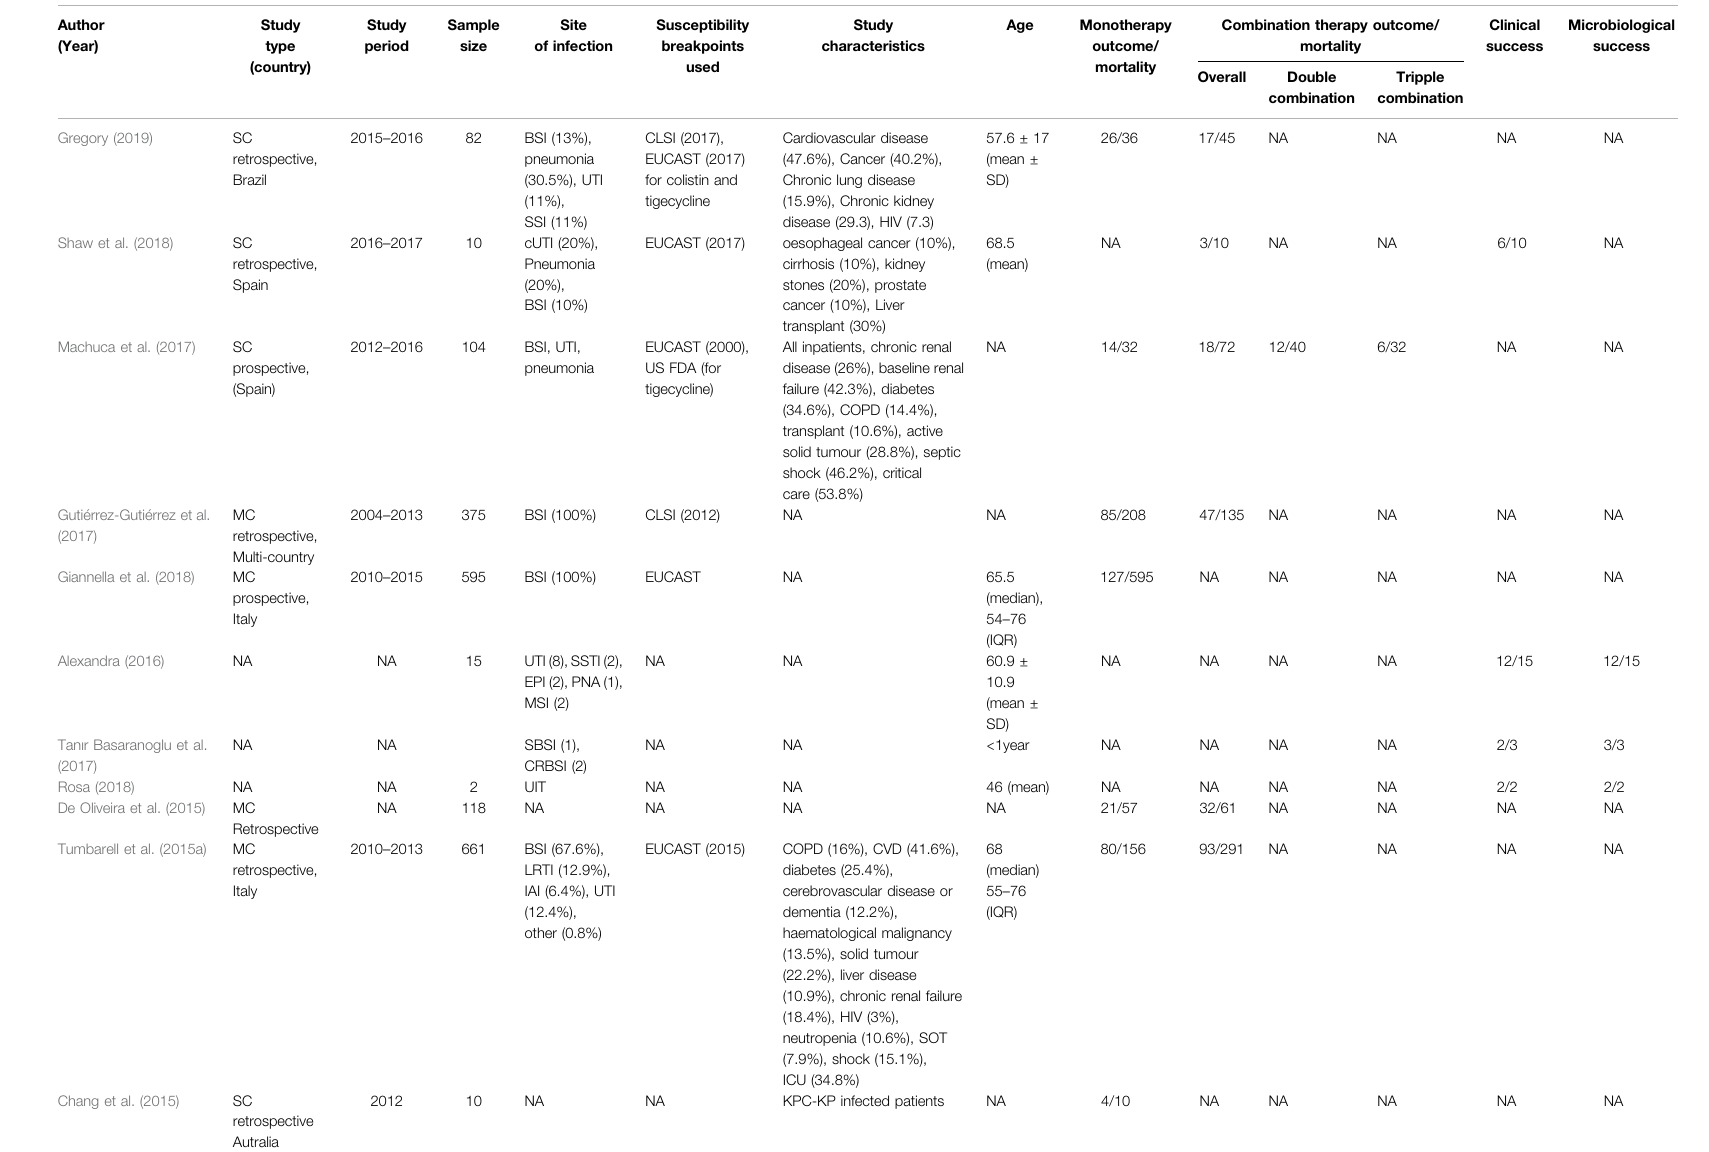
TABLE 1 | Charcteristics of included